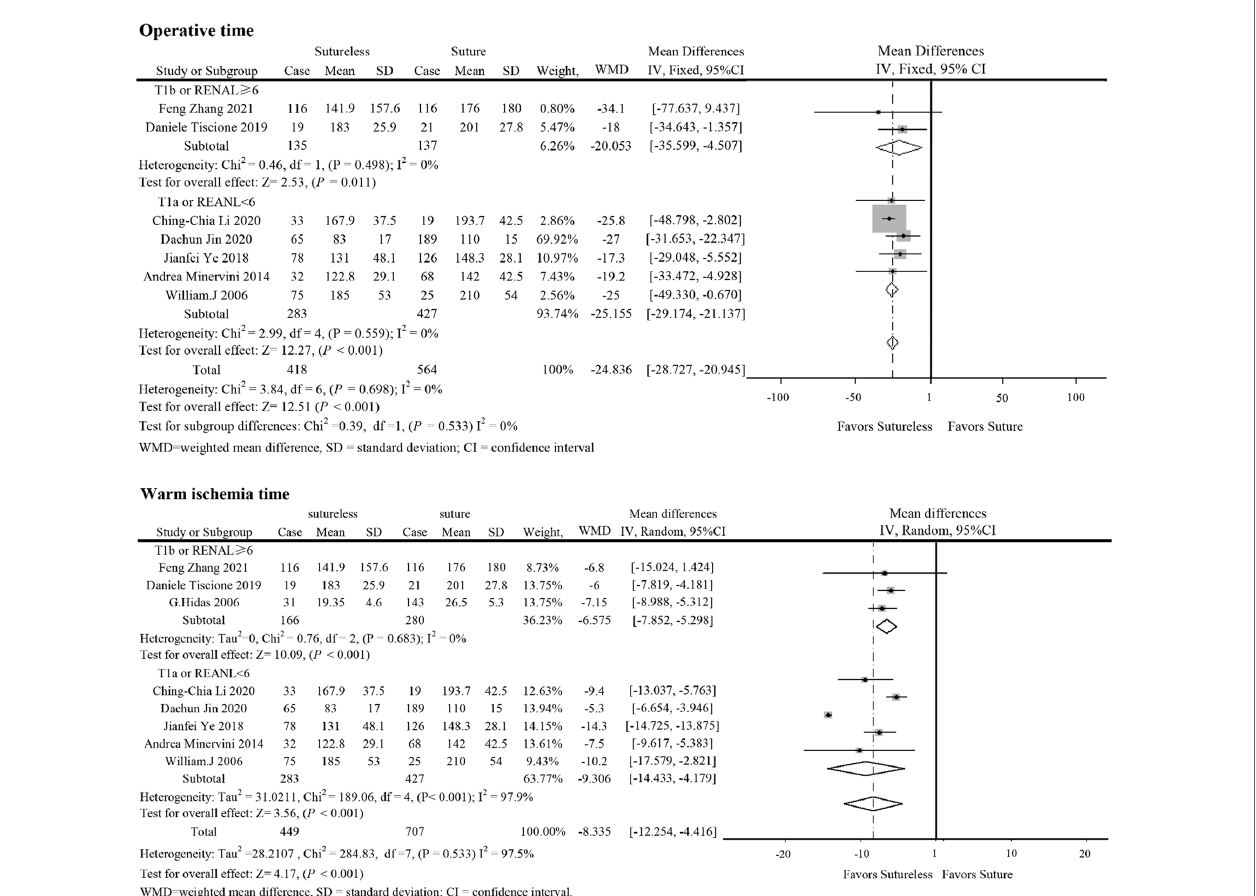
FIGURE 2 | Forest plots of operative time and warm ischemia time for sutureless versus suture partial